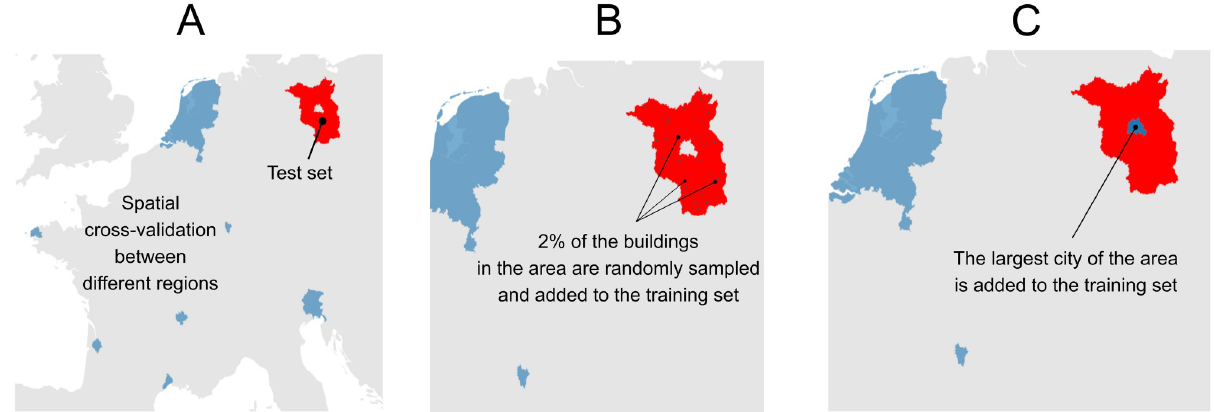
Fig 3. Map of the three experiments on the test set of Brandenburg. (A) Experiment 1: No local data are available, and the model is trained only on data from other countries. (B) Experiment 2: Scarce local data are available—we add 2% of the test set to the training set, to test the hypothesis that these data provide relevant data for training the model. (C) Experiment 3: The main city of the area is available—we add this city to the training. The areas in blue are the training set and the area in red is the test set.